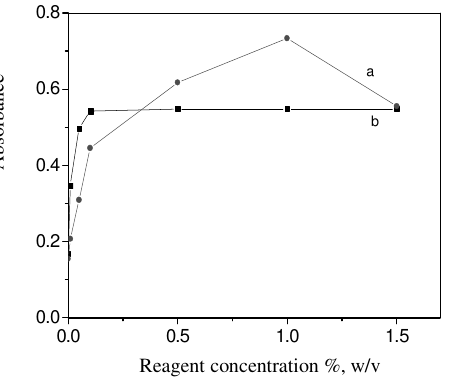
Figure 5. Effect of concentration of the reagent Tz + Cl - (a) and Phen (b) on the extraction of